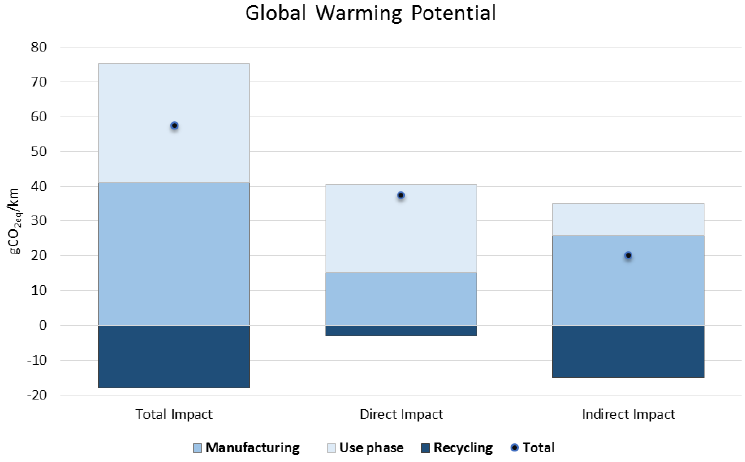
Figure 3. Global Warming Potential impact per km.